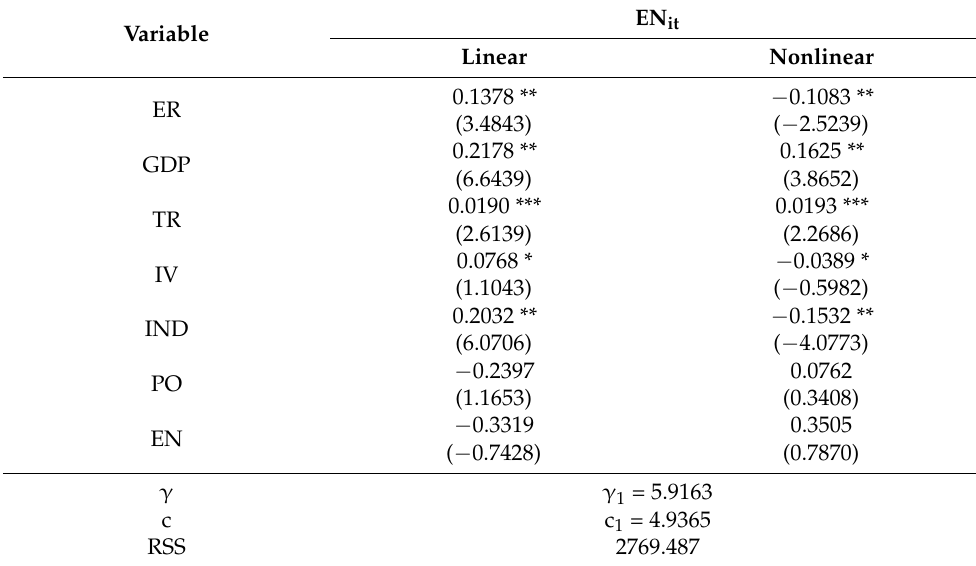
Table 9. PSTR results with energy intensity as the threshold